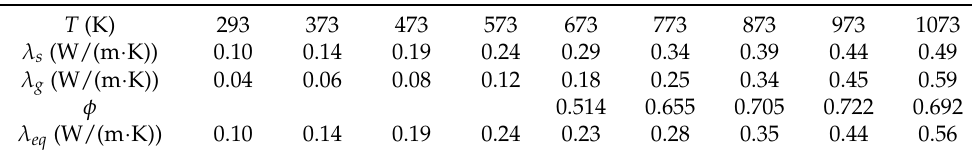
Table 4. Equivalent thermal conductivity of the intumescent coating.